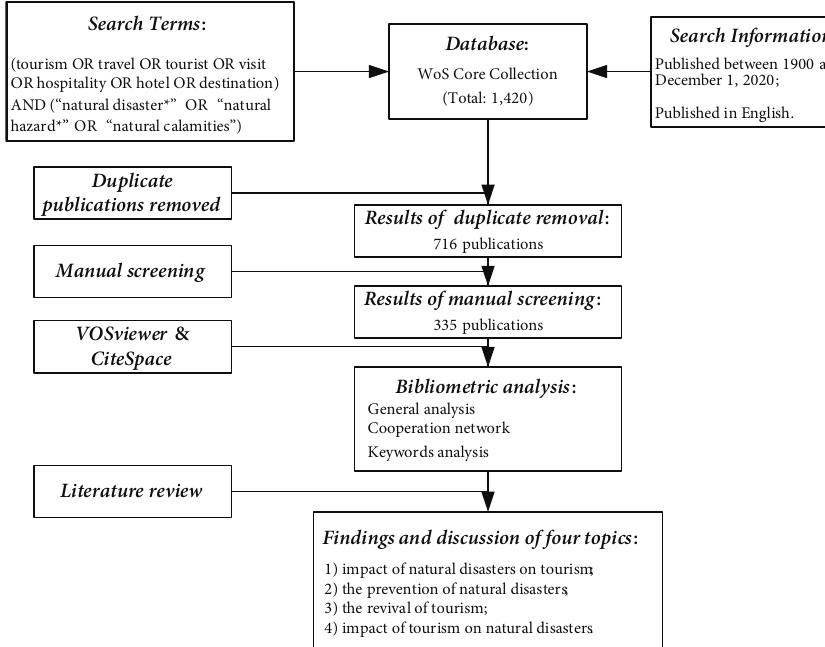
Figure 1. Methodology framework of this